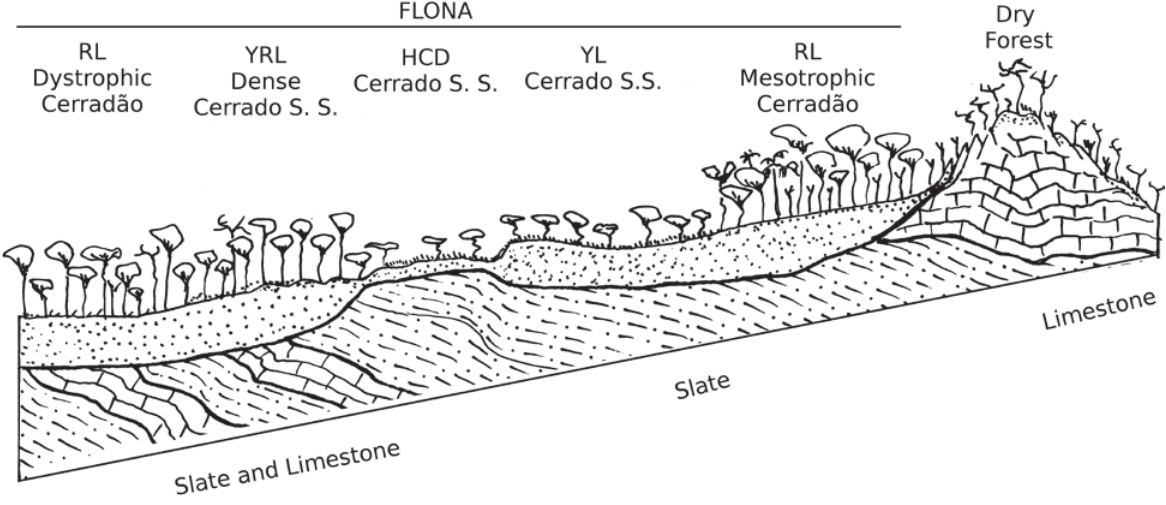
Figure 3 - Schematic geomorphologic-soil-vegetation profile. All Cerrado (savanna) and Cerradão (woodland) phytophysiognomies occur in Paraopeba National Reserve whereas Dry Forest is at northeast bound neighboring site. RL – Red Latosol, RYL – Red-Yellow Latosol, YL – Yellow Latosol, C –